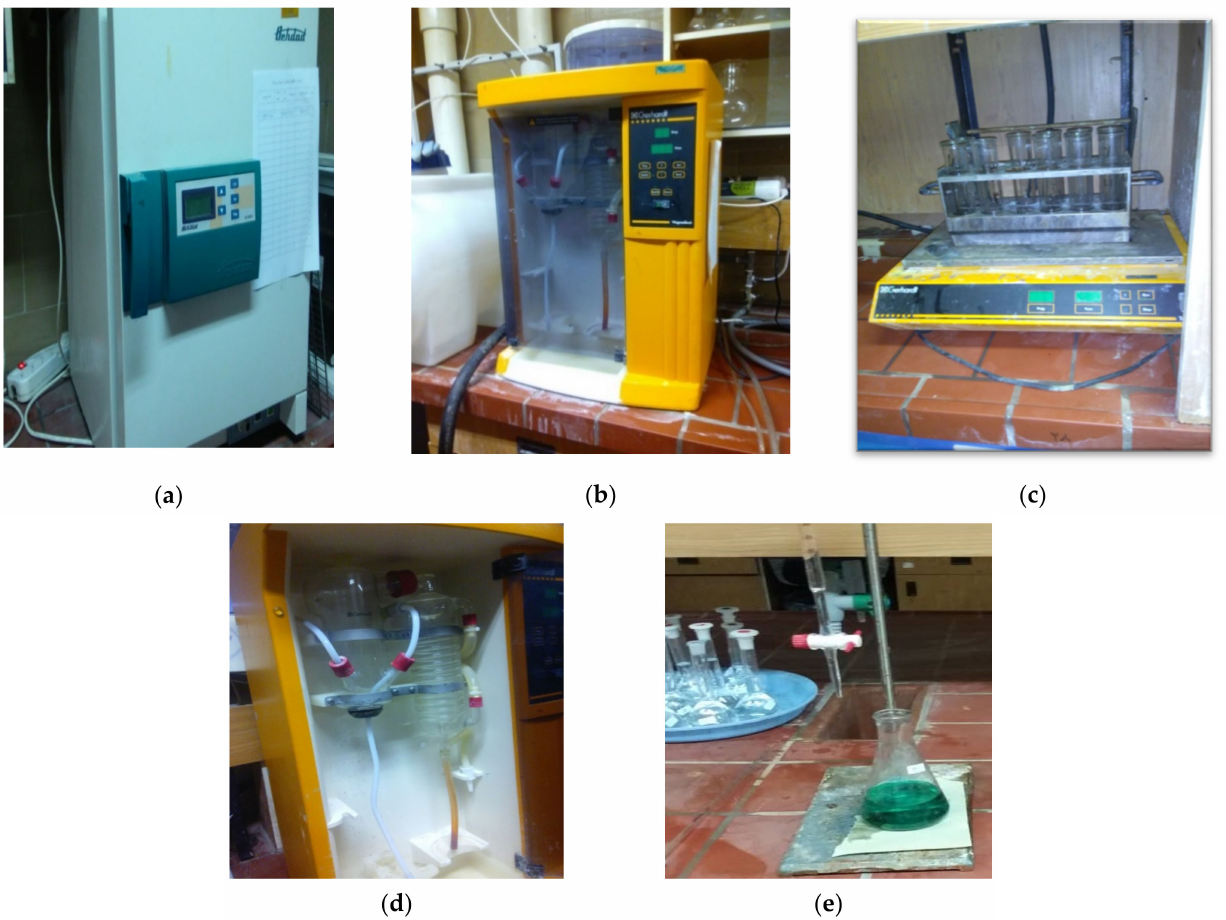
Figure 6. Laboratory equipment used for measuring the total nitrogen content of the leaves: ( a ) oven; ( b ) Kjeldahl device; ( c ) digestion; ( d ) distillation; ( e )